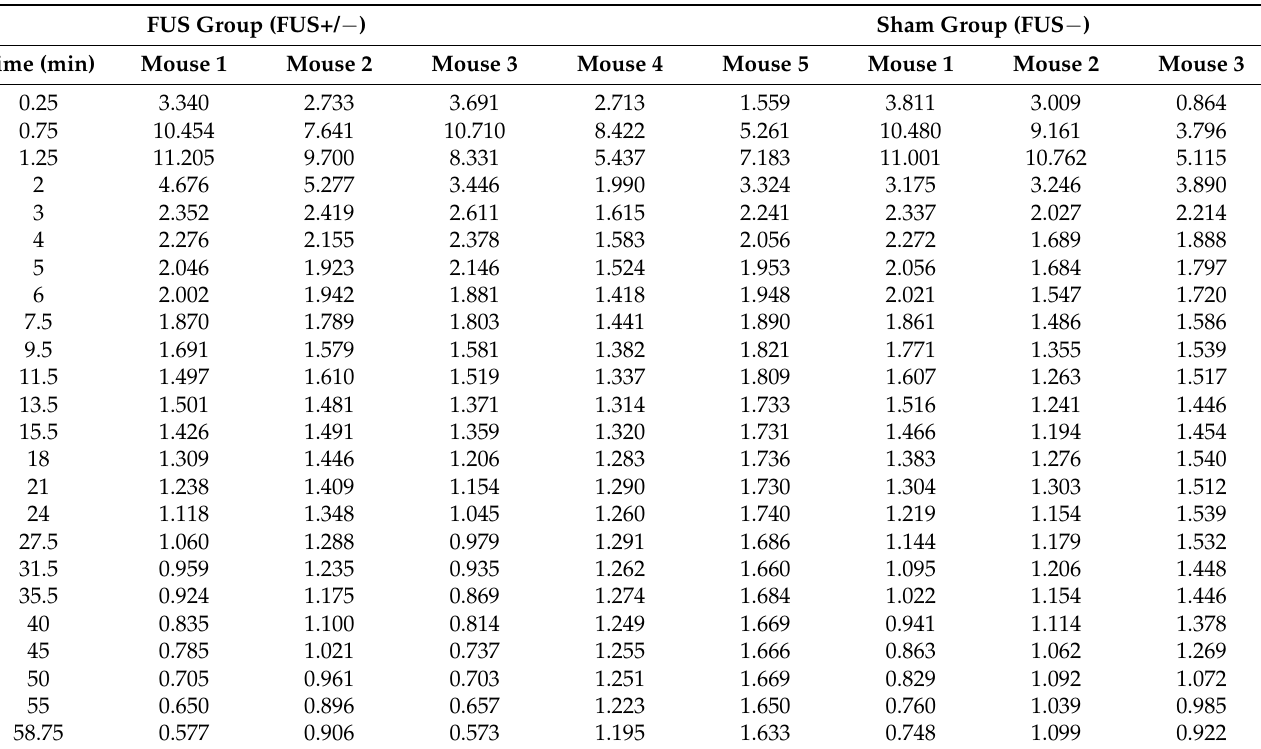
Table A3. SUV values—Blood